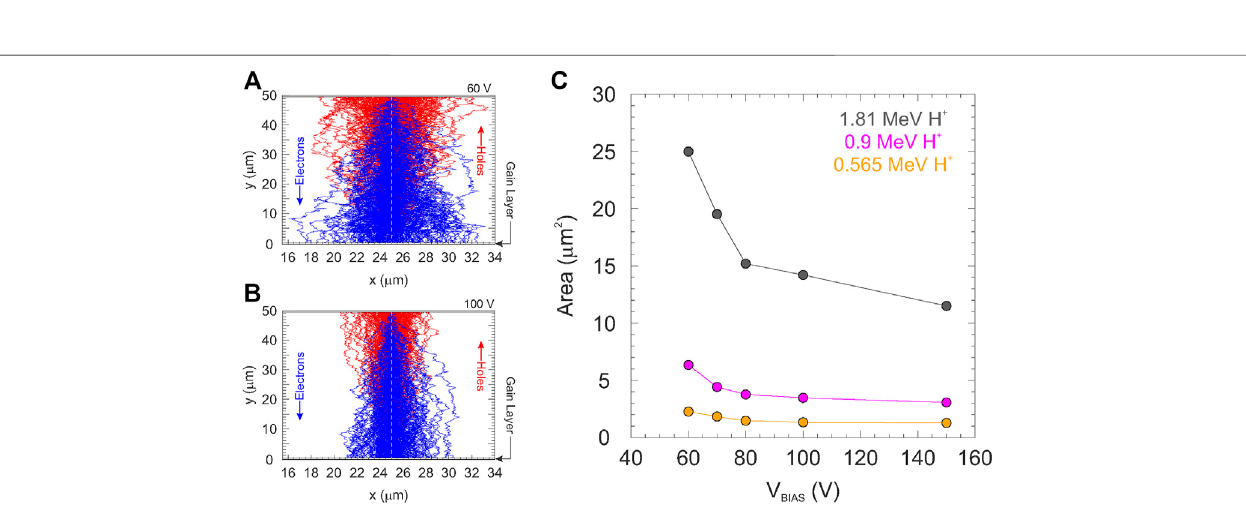
FIGURE 7 | Simulations of charge carrier trajectories in silicon exposed toprotons of1.8 MeV energy, for two different biases, 60 V (A) and 100 V (B) . Simulations areusedtocalculateFWHMofchargecloudspreadatx=0andsubsequentlythearealspreadofchargecloudingainlayer.Atright (C) ,dependence ofarealspread on bias voltage for three proton energies is given.